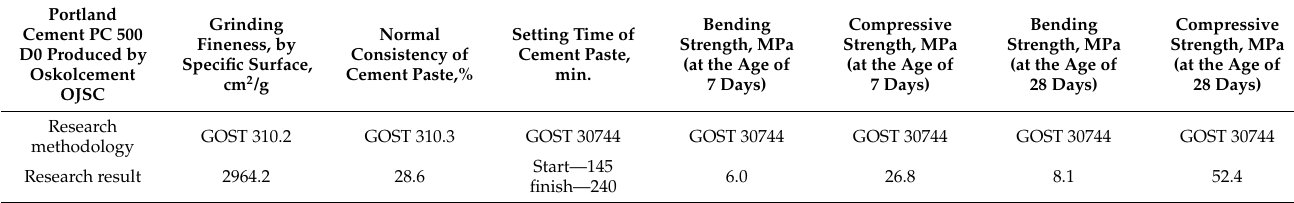
Table 1. Physical and mechanical characteristics of Portland cement.